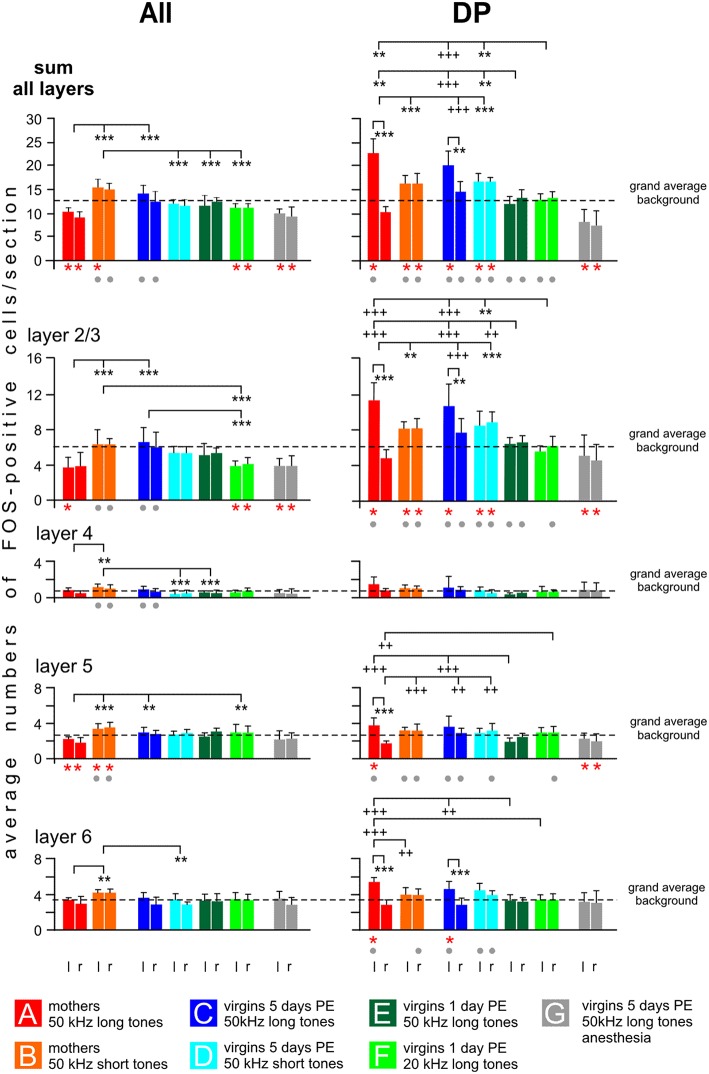
Distribution of FOS-positive cells in the cortical layers of the secondary (AII) and dorsoposterior (DP) fields of the AC. The plotted values (means with standard deviations) relate to the left (l) and right (r) hemisphere and to cortical layers 2/3, 4, 5, 6 and to the sum of all layers. Significant differences (p < 0.01, at least) between the grand average background of a group (calculation, see text) and the plotted group values are indicated by red stars below the respective group bars. Significant differences (p < 0.01, at least) between values of the anesthetized animals (group G) and any values of the others groups are indicated by gray dots below the bars of the group of non-anesthetized animals. Significant differences between values of groups or between the left and right hemisphere of a given group are indicated above the histograms. Stars (** or ***) are used in cases when the inter-group differences relate to both hemispheres, plus signs (++ or +++) are used when the inter-group differences relate only to one hemisphere pointed at by the vertical dashes. p < 0.01 (** or ++); p < 0.001 (*** or +++). For further explanations, see text.